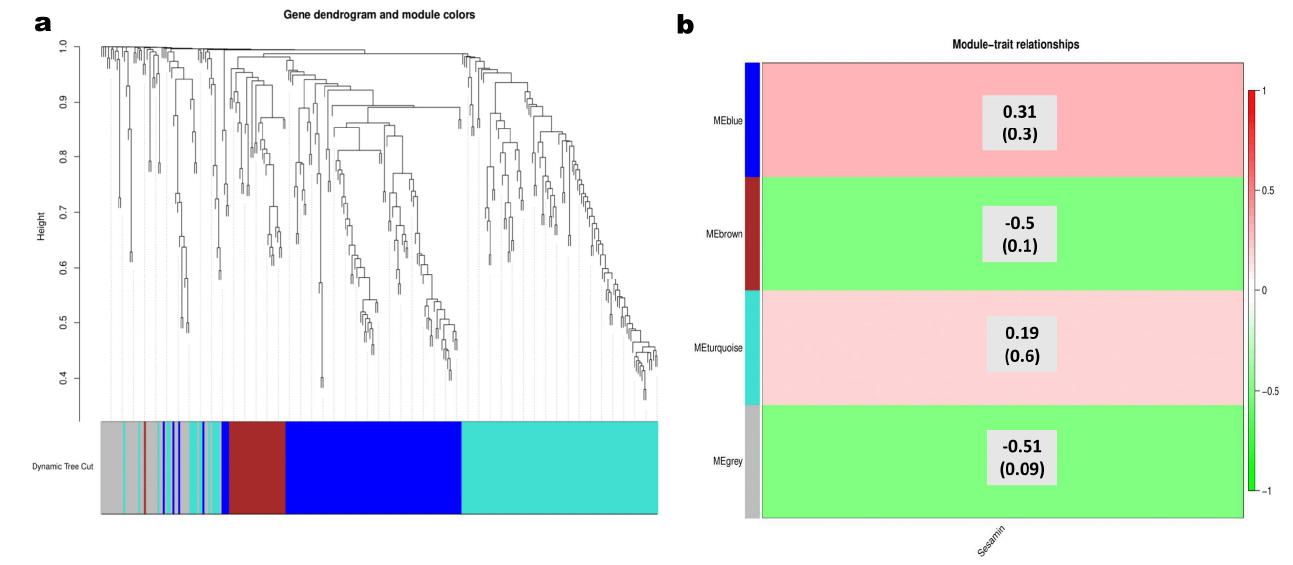
Figure 5. WGCNA results of SiNST1 , SiMYBs , and predicted CYP81Q1-related genes in developing sesame seeds. ( a ) Classification of the analyzed genes in four modules represented by the blue, brown, grey, and turquoise colors. The genes with higher weight values have the most extended height on the dendrogram. ( b ) Heatmap of the correlation of WGCNA modules with sesamin content. The ordinate and abscissa indicate modules and the trait (sesamin), respectively. The green or red colors indicate the correlation coefficients (the top number in each cell). On the right is the color ruler. The bottom numbers (numbers in brackets) indicate the p -values.